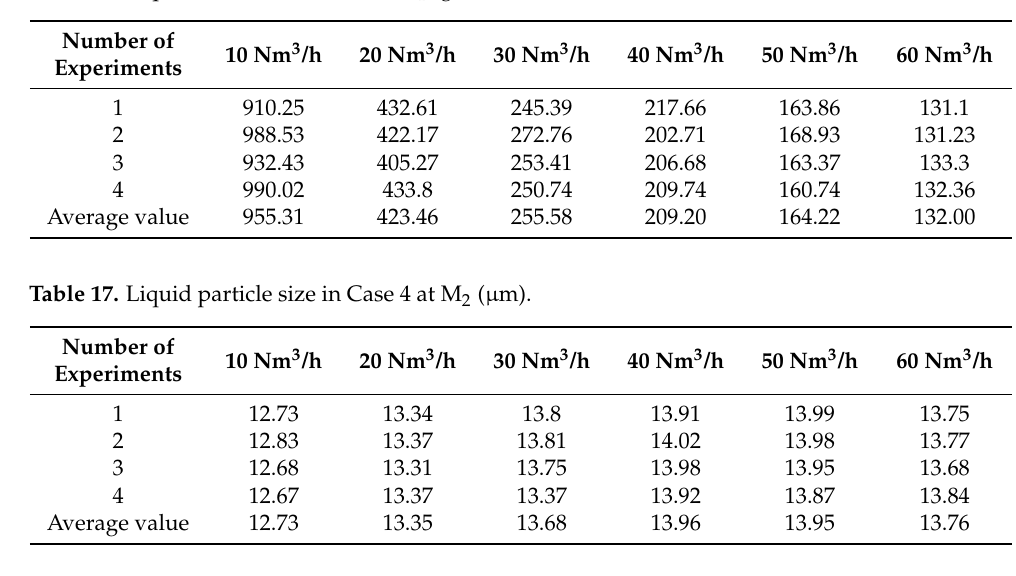
Table 16. Liquid content in Case 4 at M 1 (g/m 3 ).